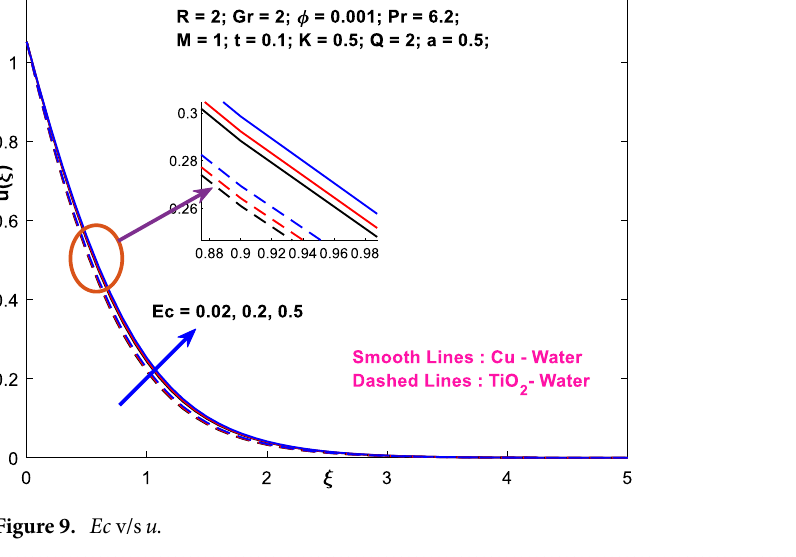
Figure 9. Ec v/s u .